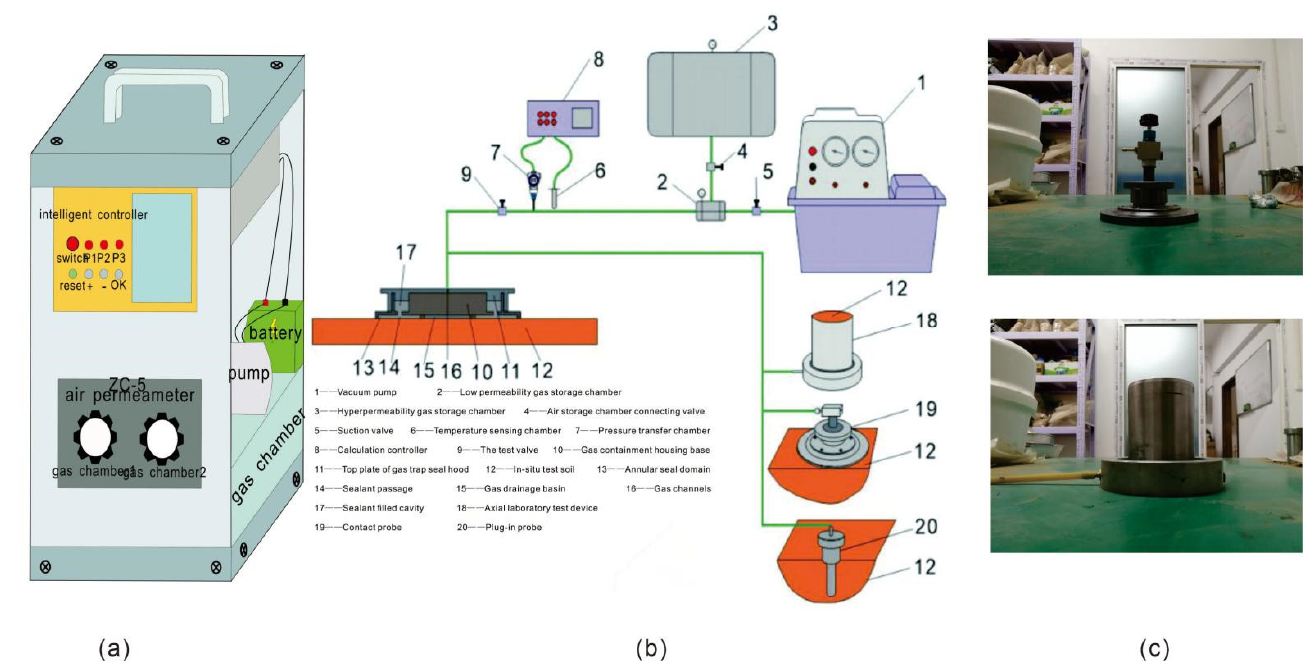
Figure 3. Schematic diagram of the transient device for the measurement of the soil vacuum attenuation permeability rate: ( a ) the host of the portable vacuum attenuation permeability meter; and ( b ) the main structure of the vacuum attenuator (including an external air chamber, in situ measurement probe, and indoor measurement sample cylinder). ( c ) Pictures of the test instrument.